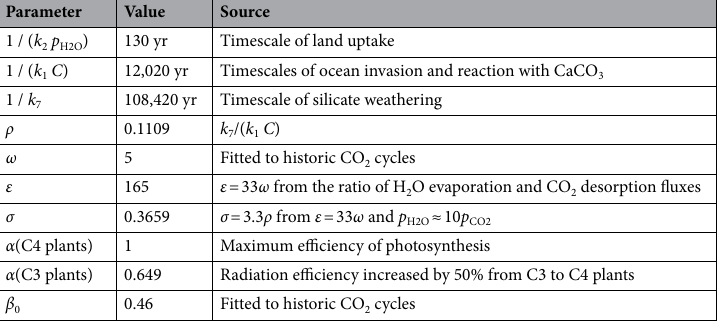
Table 1. Parameters employed in the simulations with the Glaciator , including the methods used in their estimates.